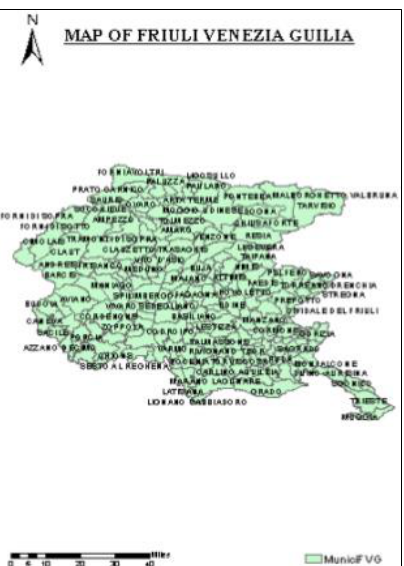
Figure 1-4-2 Map of Friuli Venezia Giulia Fig 1-4-1 and 1-4-2 show map of Italy and study region Friuli Venezia Giulia respectively. Italy is a unitary parliamentary republic country in Europe, with a long Mediterranean